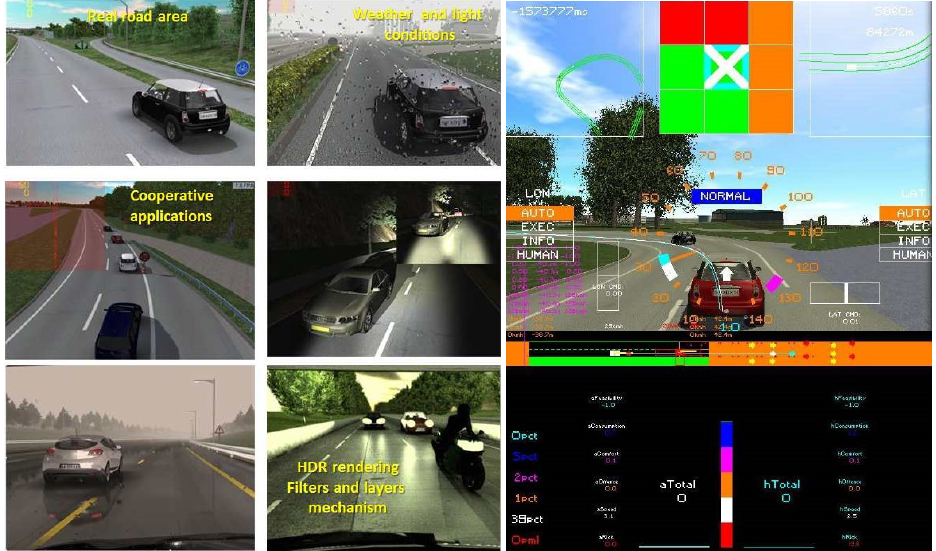
Figure 11. Pro-SiVIC, a generic and physically realistic simulation platform for sensors, vehicles, and environment. Right: Co-Pilot